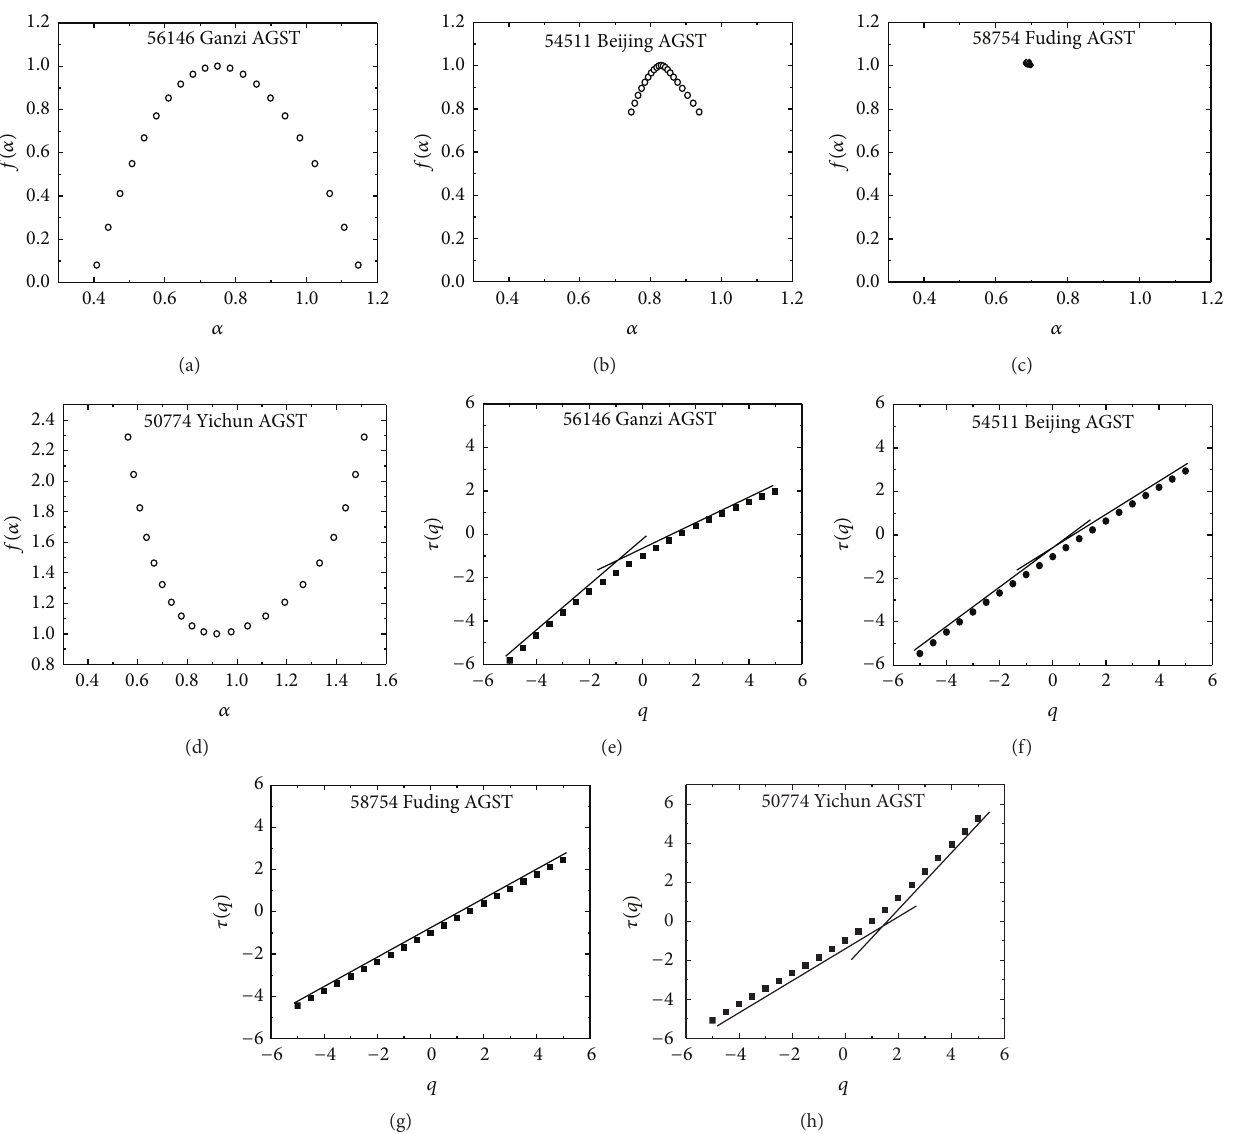
Figure 5: (a) The multifractal spectra 𝑓(𝛼) for the AGST record of station Ganzi. (b), (c), and (d) The analog to (a) but for Beijing, Fuding, and Yichun. (e) The scaling exponent 𝜏(𝑞) for the AGST record of station Ganzi. (f), (g), and (h) The analog to (e) but for Beijing, Fuding, and